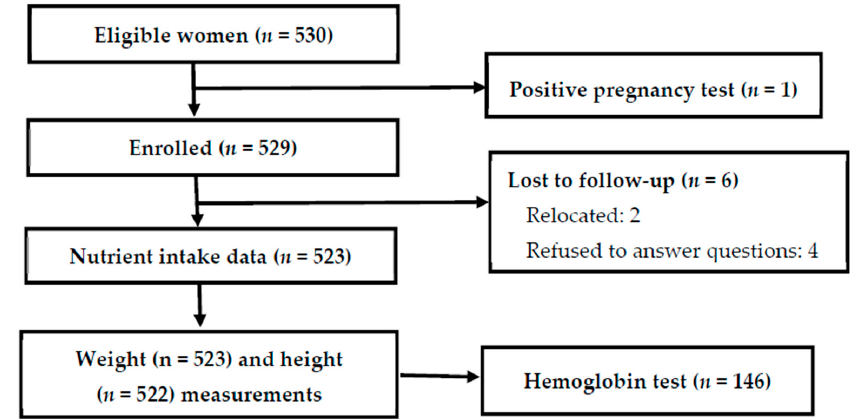
Figure 1. Subject flow through the study and reasons for withdrawal or loss to follow-up.